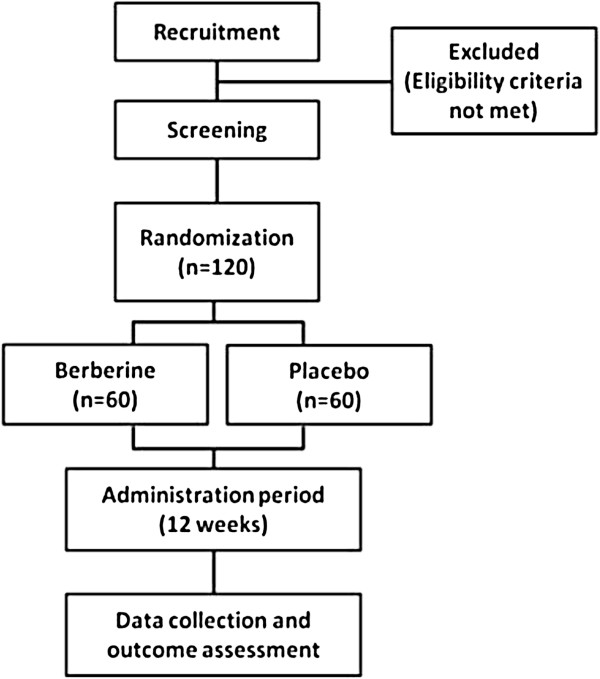
Study flowchart.